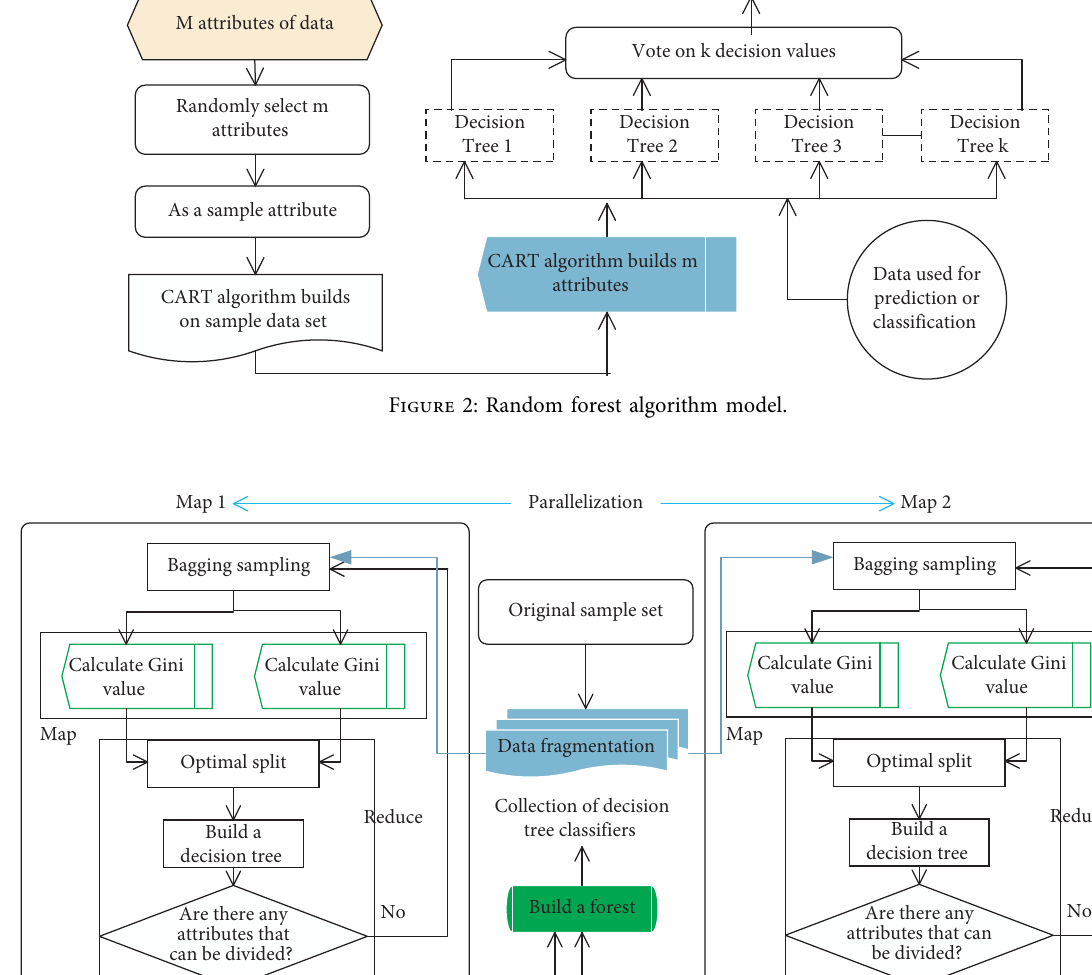
Figure 3: Parallelization of decision tree